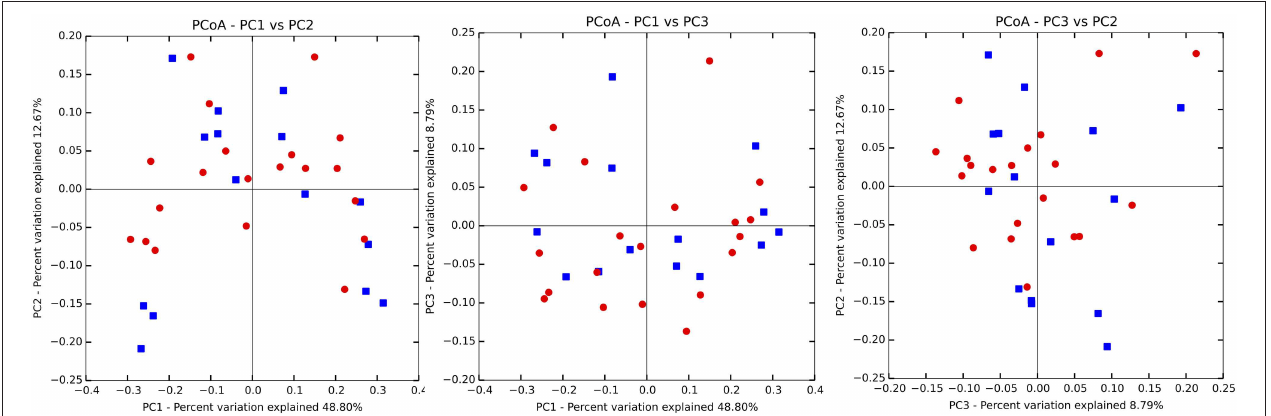
FIGURE 4 | Principal coordinate ordination plots based on the weighted Unifrac beta diversity distance. P, blue color; H, red color. No clustering of P and H samples was evident.